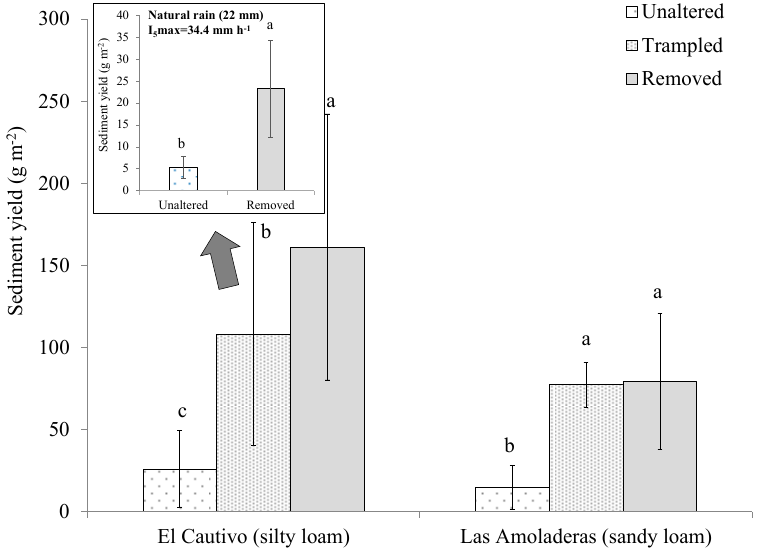
Figure 8. Sediment yield (g m − 2 ) in unaltered, trampled and removed well-developed cyanobacterial biocrusts after 1 h of rainfall simulation with a constant intensity of 50 mmh − 1 , on silty loam (El Cautivo) and sandy loam (Las Amoladeras) soils. Sediment yield in unaltered and removed cyanobacterial biocrusts during an intense natural rain at El Cautivo is shown in the upper left figure. Different letters indicate significant differences ( p < 0.05) among treatments at each site.